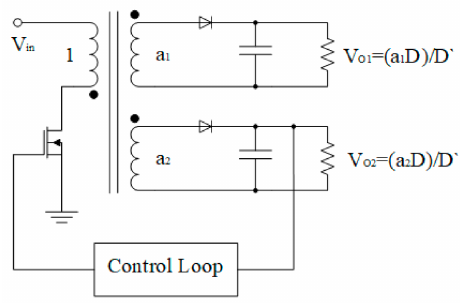
Figure 1. A typical regulated flyback